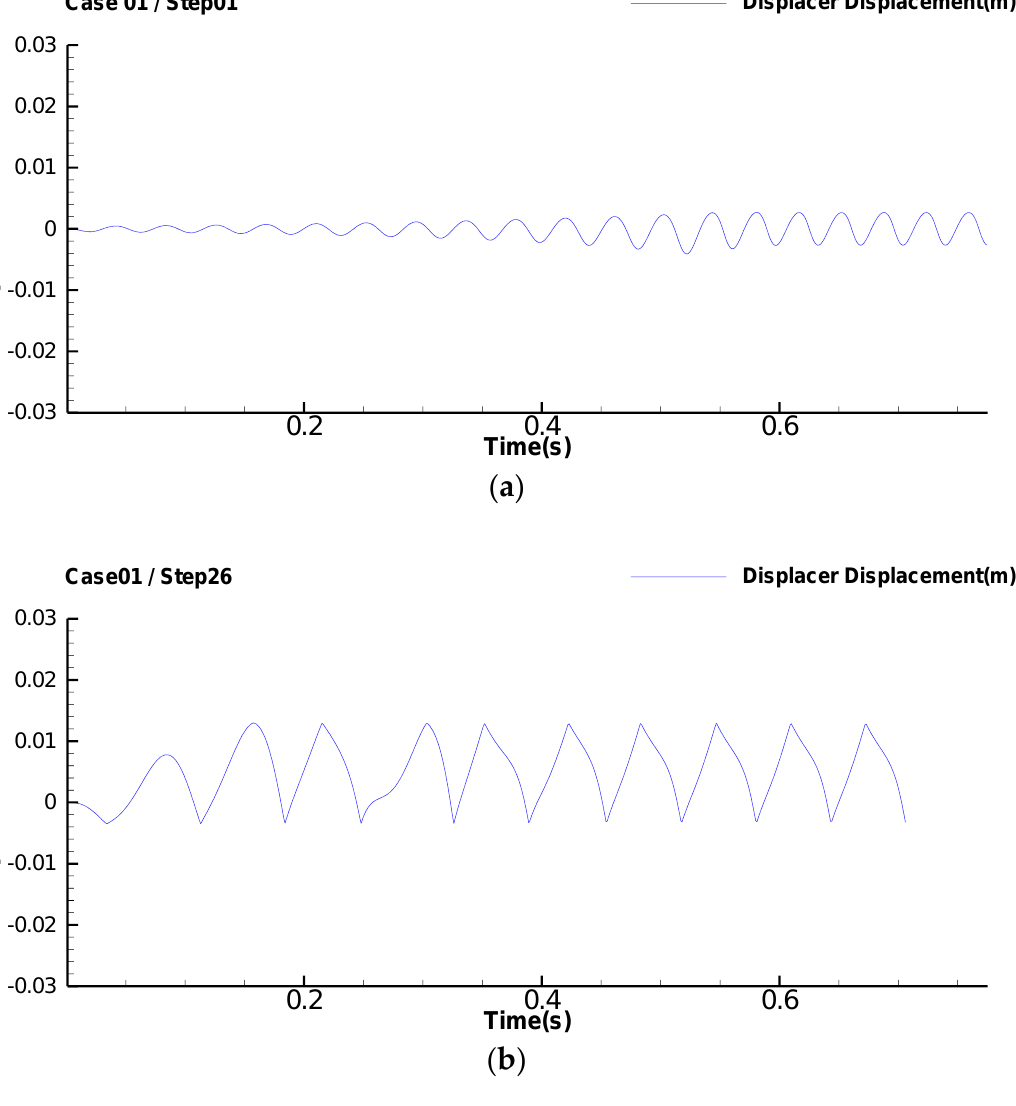
Figure 7. Optimization with the VSCGM for the maximum stroke of the displacer in Case 1: ( a ) initial design; ( b ) optimal design reached at the 26th step. Table 3. Optimal design of Case